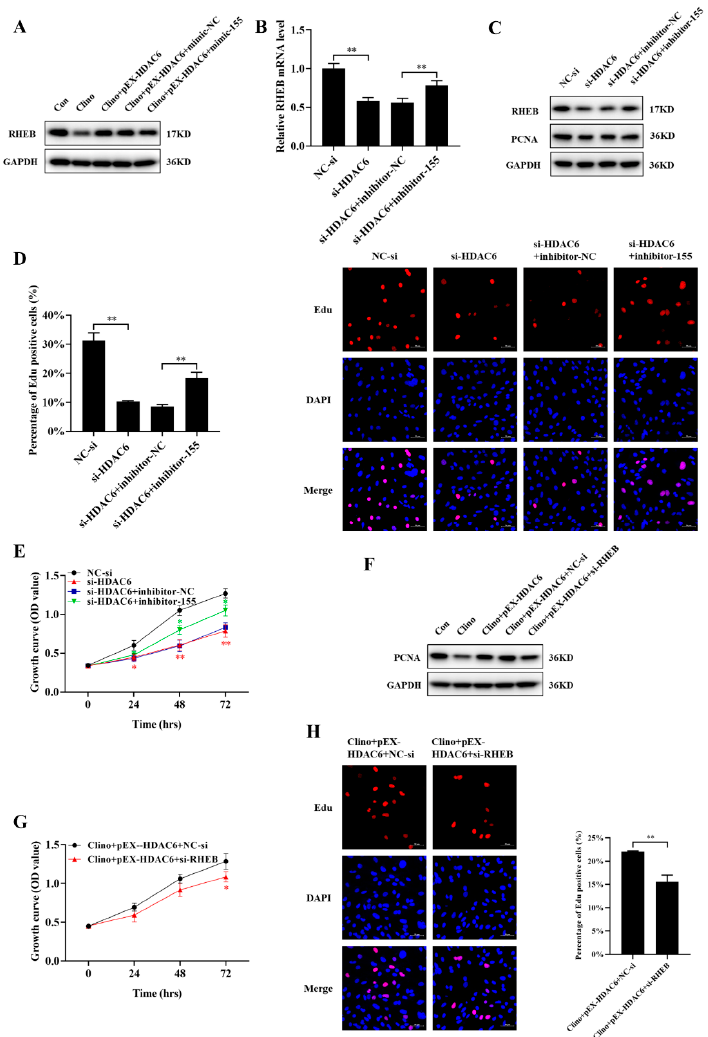
Figure 7. HDAC6 promotes microvascular endothelial cell proliferation by inhibiting the miR-155- 5p/RHEB axis. ( A ) RHEB protein expression was analyzed by Western blotting after microvascular endothelial cells were transfected with pEX-HDAC6 alone or pEX-HDAC6 plus mimic-155 and subjected to clinorotation unloading for 48 h (N = 3). (B ) qRT-PCR analysis of RHEB level after cotransfection with siRNA-HDAC6, inhibitor-155-5p, and their negative control into bEnd.3 cells (N = 3). ( C ) Western blotting analysis of RHEB and PCNA protein expression (N = 3). ( D ) The EdU incorporation assay was analyzed by confocal microscopy (N = 3). Scale bar, 50 µ m. ( E ) Cell proliferation was evaluated by CCK-8 assay at 24–72 h (N = 3). The symbol *(Red) represents the NC-si vs. si-HDAC6 group; the symbol *(Green) represents the si-HDAC6 plus inhibitor-NC vs. si-HDAC6 plus inhibitor-155 group. ( F ) PCNA protein expression was analyzed by Western blotting after microvascular endothelial cells were transfected with pEX-HDAC6 alone or pEX-HDAC6 plus siRNA-RHEB and subjected to clinorotation unloading for 48 h (N = 3). ( G ) Cell proliferation was evaluated by CCK-8 assay at 24–72 h (N = 3). ( H ) The EdU incorporation assay was analyzed by confocal microscopy (N = 3). Scale bar, 50 µ m. * p < 0.05, ** p < 0.01 vs.